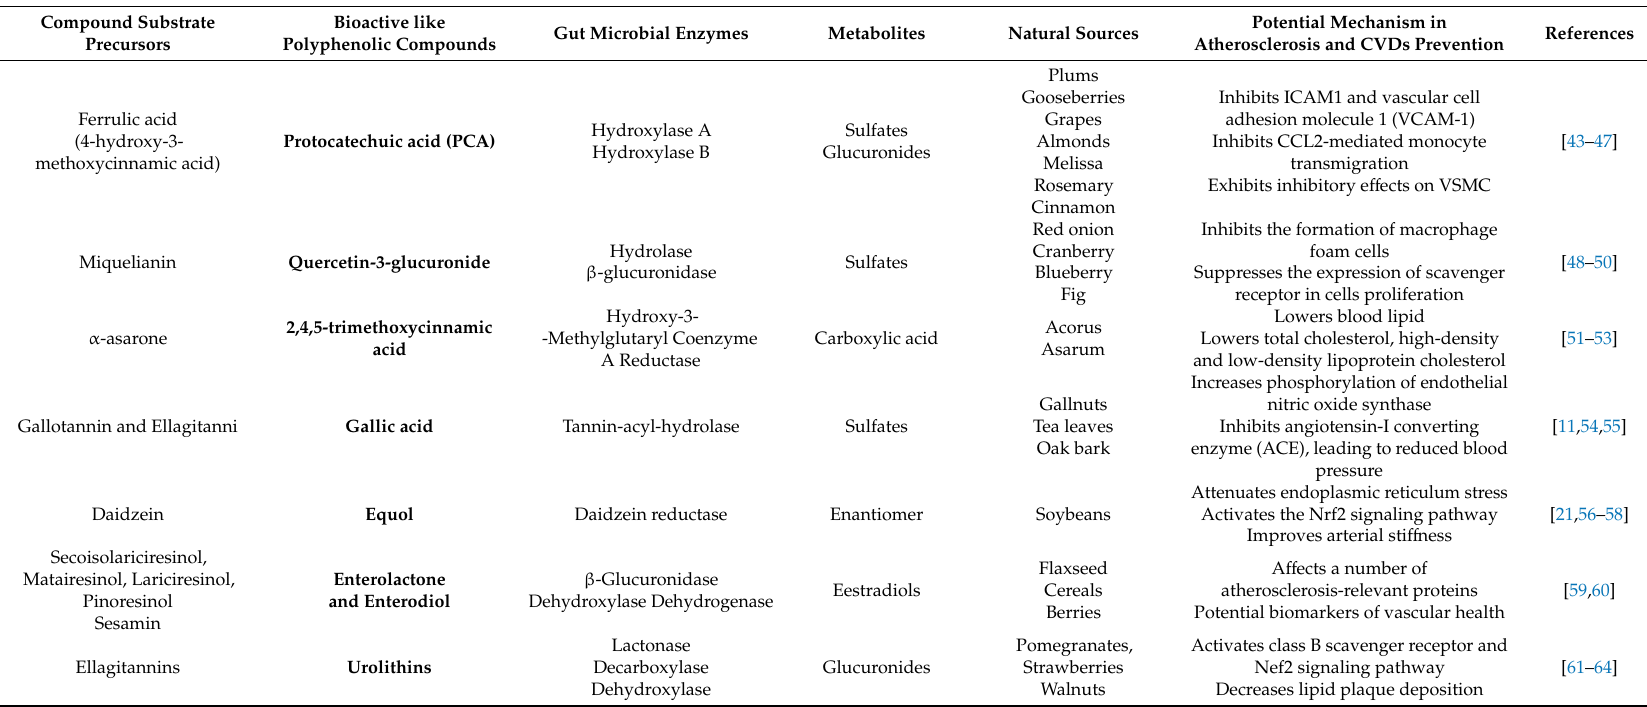
Table 1. Natural products, their precursors and corresponding bioactive compounds, metabolites forms and gut enzymes for their production with potential beneficial e ff ects on the pathological process of atherosclerosis and